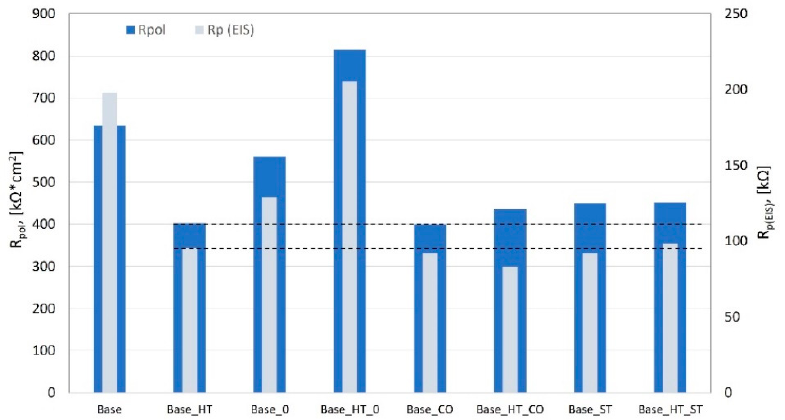
Figure 8. Comparison of polarization resistance values found by the Tafel and EIS methods.